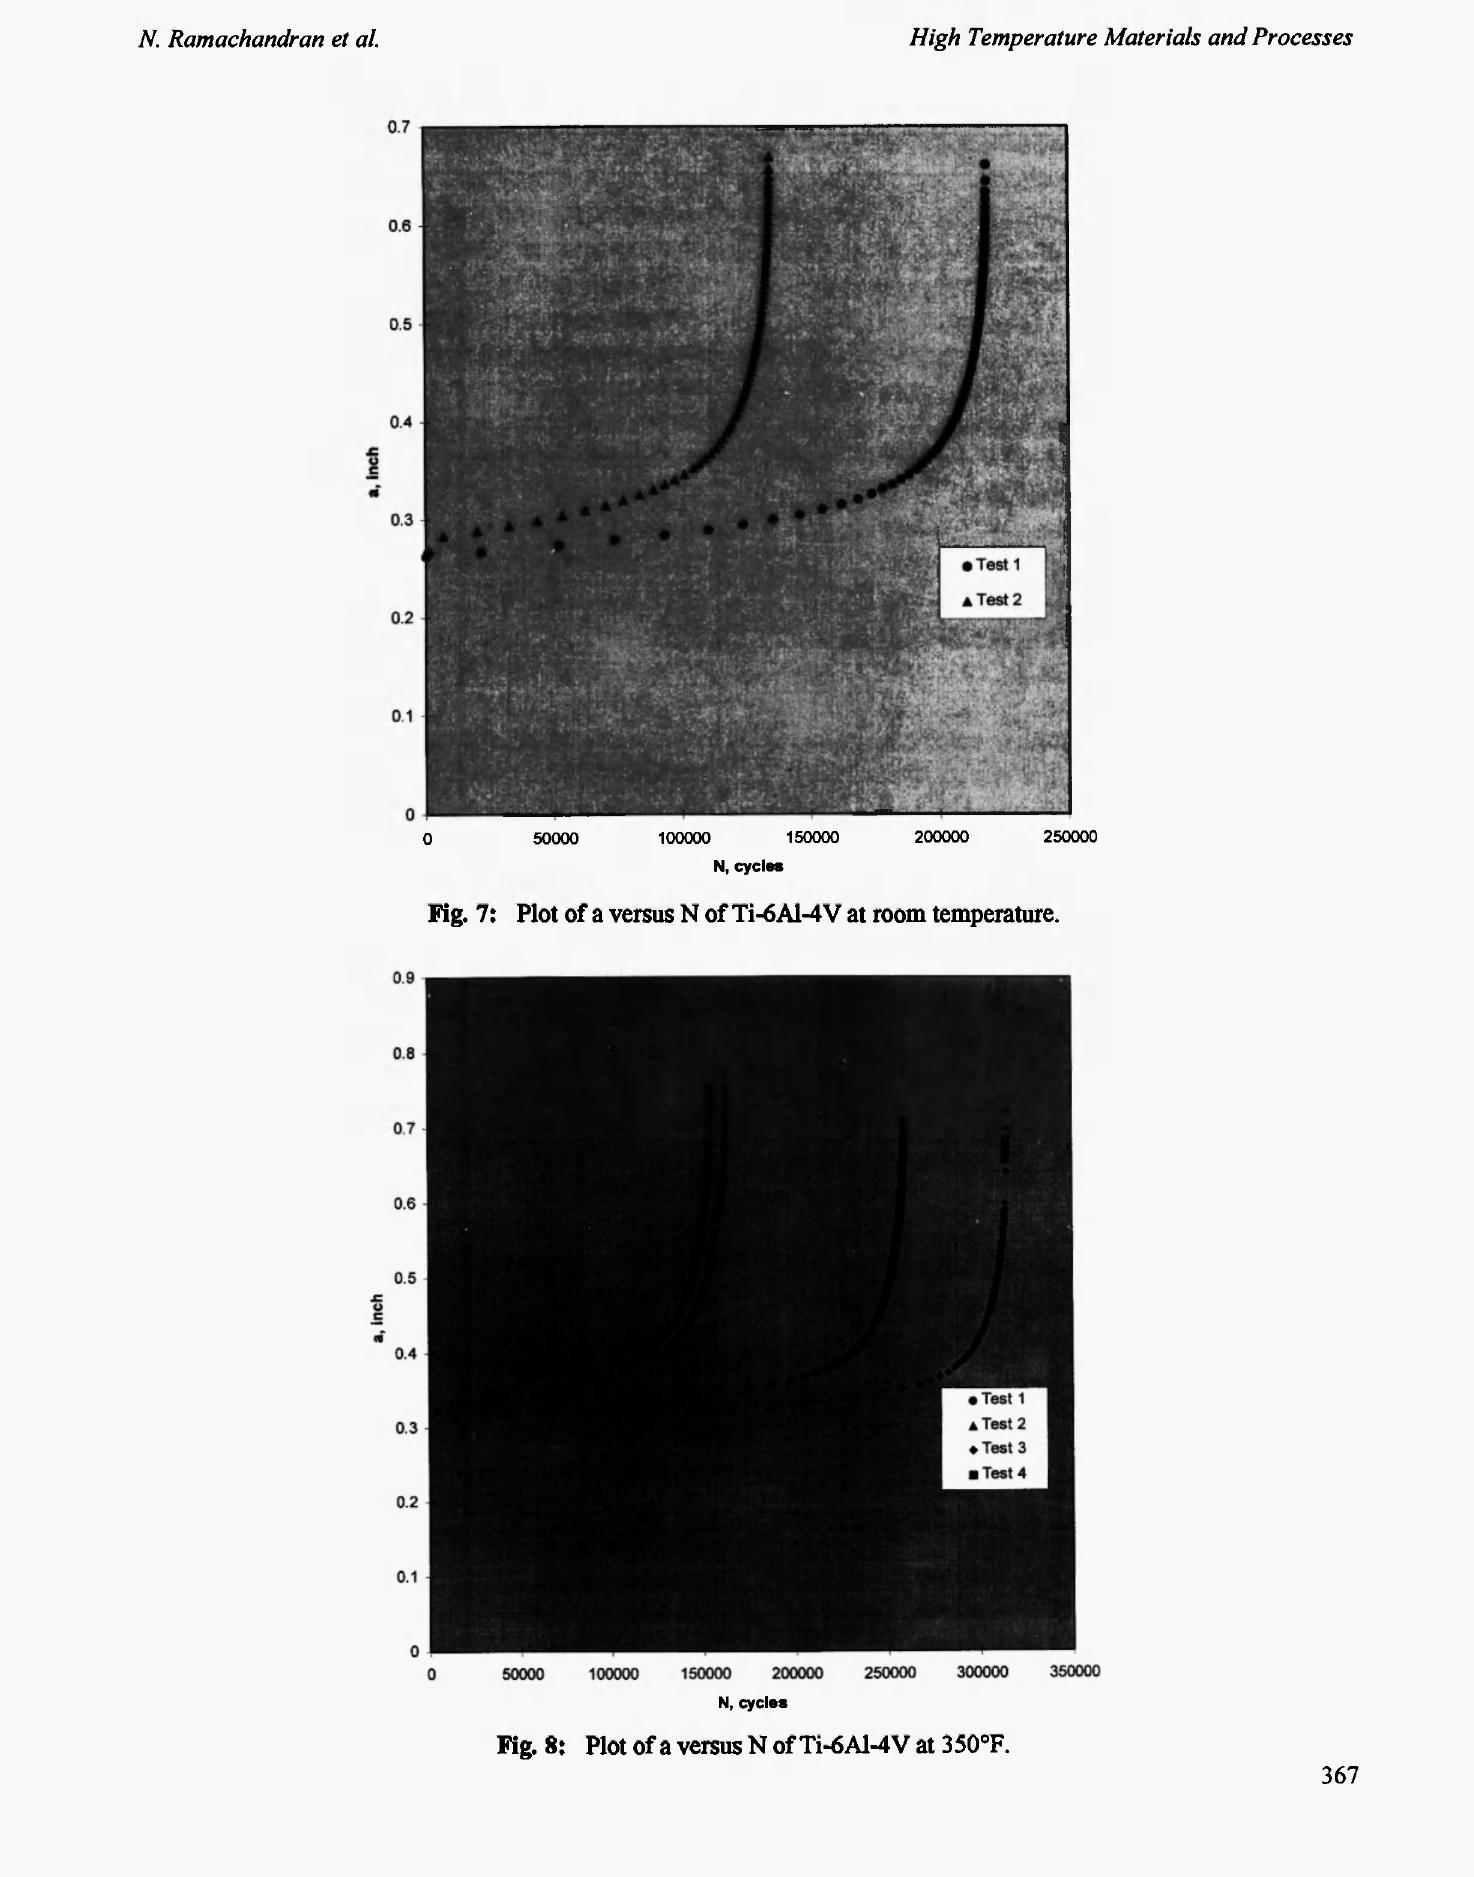
Fig. 7: Plot of a versus Ν of ΤΪ-6Α1-4 V at room temperature.